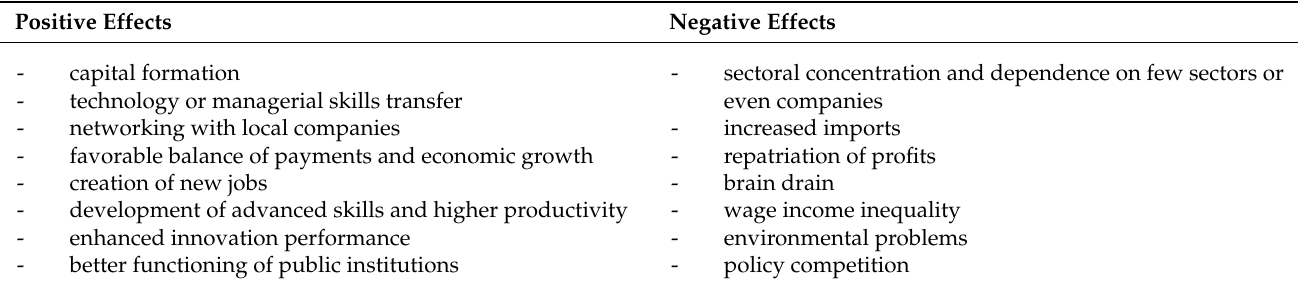
Table 1. Positive and negative effects of inward FDI on a host country (own processing according to